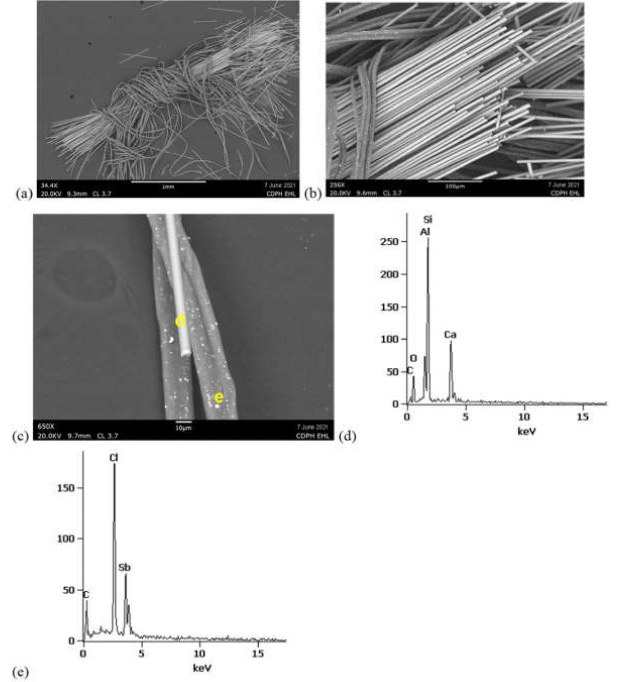
Figure 7. SEM-EDS from FG-3 inner sock. ( a , b ) Cut bundle of fiberglass wrapped in synthetic fibers. ( c ) One fiberglass fiber and two synthetic fibers with characteristic bright regions. ( d ) EDS acquired from fiberglass region marked in ( c ) showing Si, Al, and Ca. ( e ) EDS from bright spot in synthetic fiber marked in ( c ) exhibiting Cl and Sb.